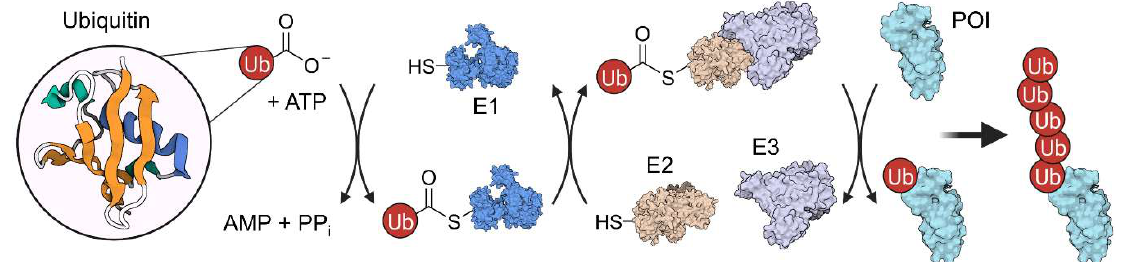
Figure 3. Ubiquitination mechanism involves three different enzymes (E1–E3) and is ATP-dependent. First, the ubiquitin peptide is transferred to an E1 enzyme under ATP consumption. Then, ubiquitin is further transferred to the E2 protein in an transthioesterification reaction. Subsequently, an E2:E3 complex forms, which can ubiquitinate the protein of interest (POI) in an iterative process.